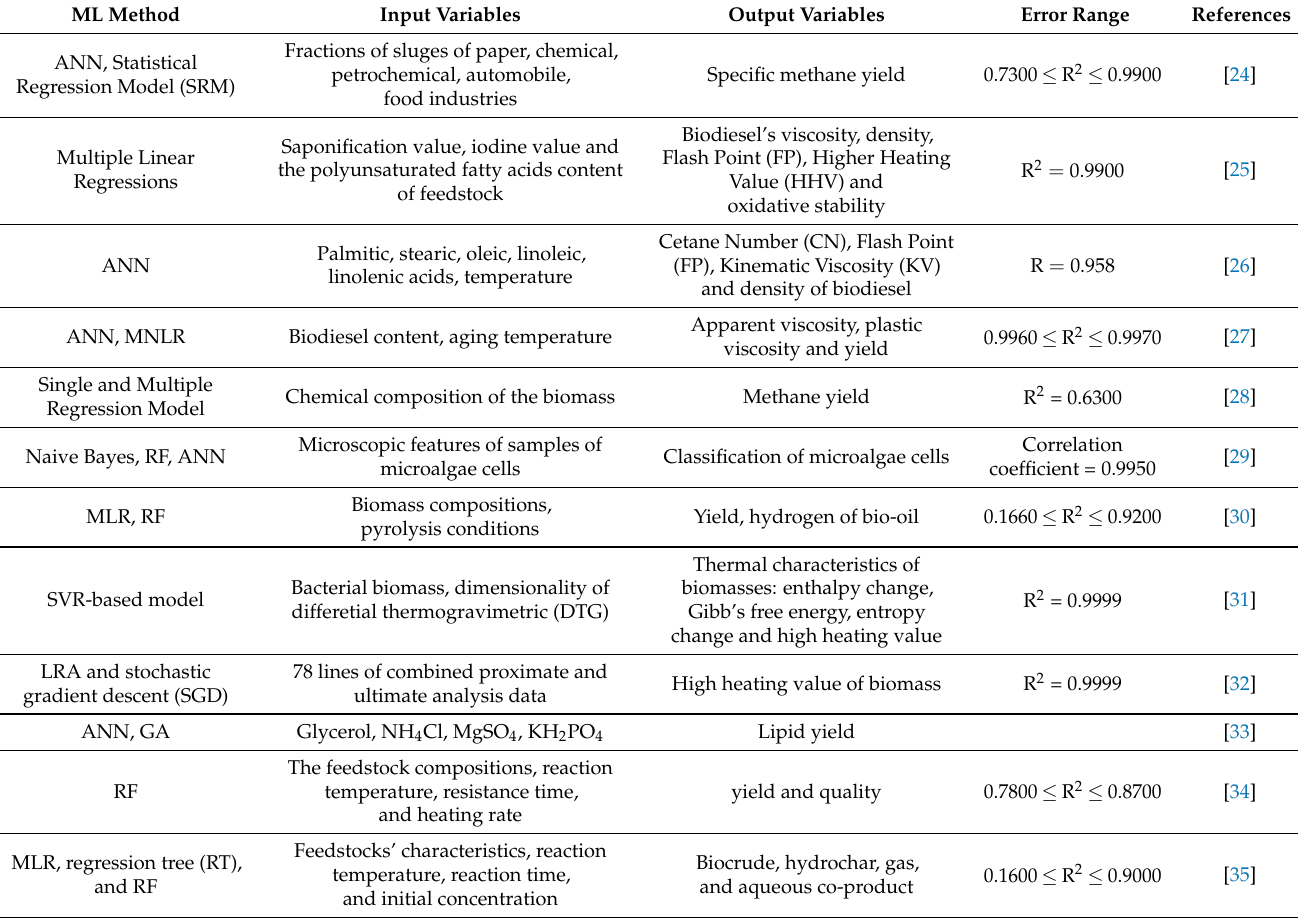
Table 3. Summary of ML applications in the feedstock